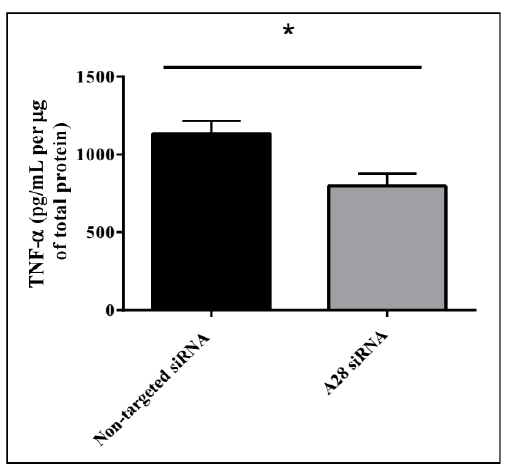
Figure 9. Decreasing ADAM28 expression reduces liver TNF- α levels in high fat diet (HFD) fed mice. Mean + SEM; * p < 0.05; n = 3 mice/group.